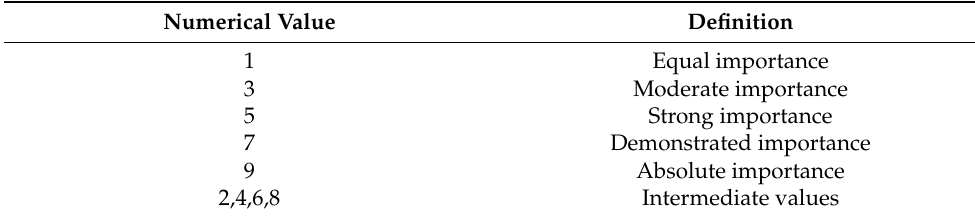
Table 5. Saaty’s Scales for Pairwise